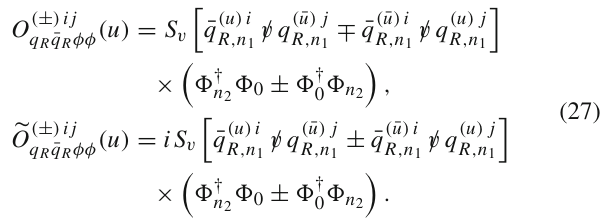
Fig. 5 One-loop contributions of the operators (cid:4) O (cid:4) O ( − ) ij (right) to the S → Zh decay q R ¯ q R φφ